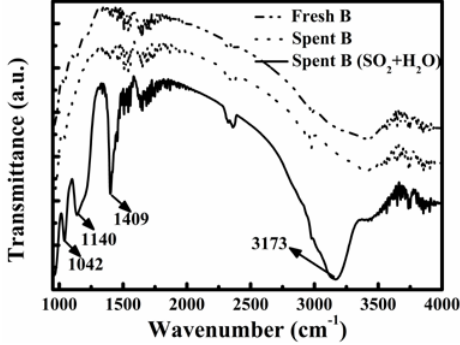
Figure 6. FT-IR spectra of fresh and spent catalyst B after tests in different simulated flue gases.